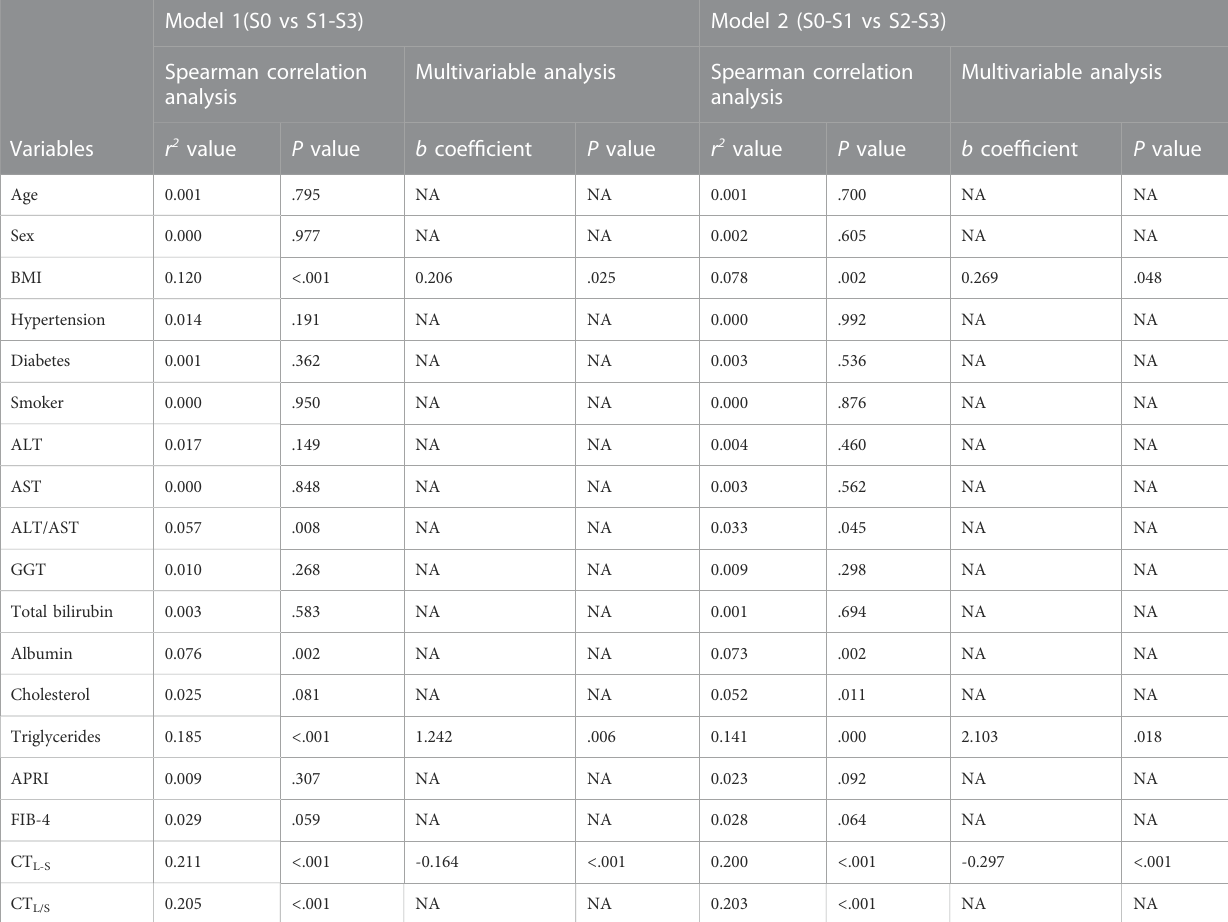
TABLE 2 Clinical characteristics selection in the training cohort related to liver